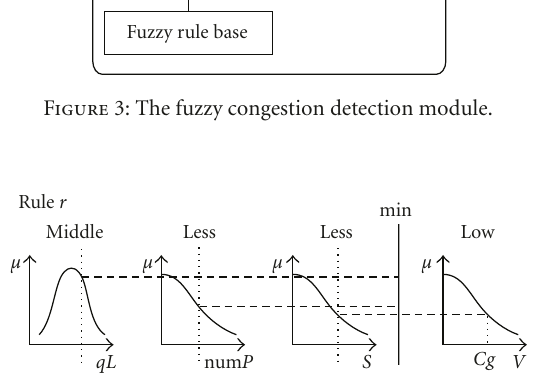
Figure 4: The reasoning procedure for Tsukamoto defuzzification method.